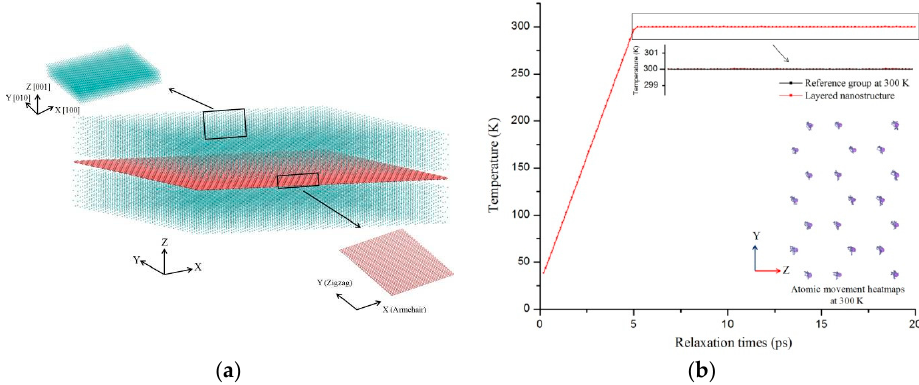
Figure 2. Graphene/copper layered composites. ( a ) Perspective side-view of graphene/copper layered composites model. Blue color represents copper atoms and red color represents carbon atoms. ( b ) Relaxation process of layered composites.